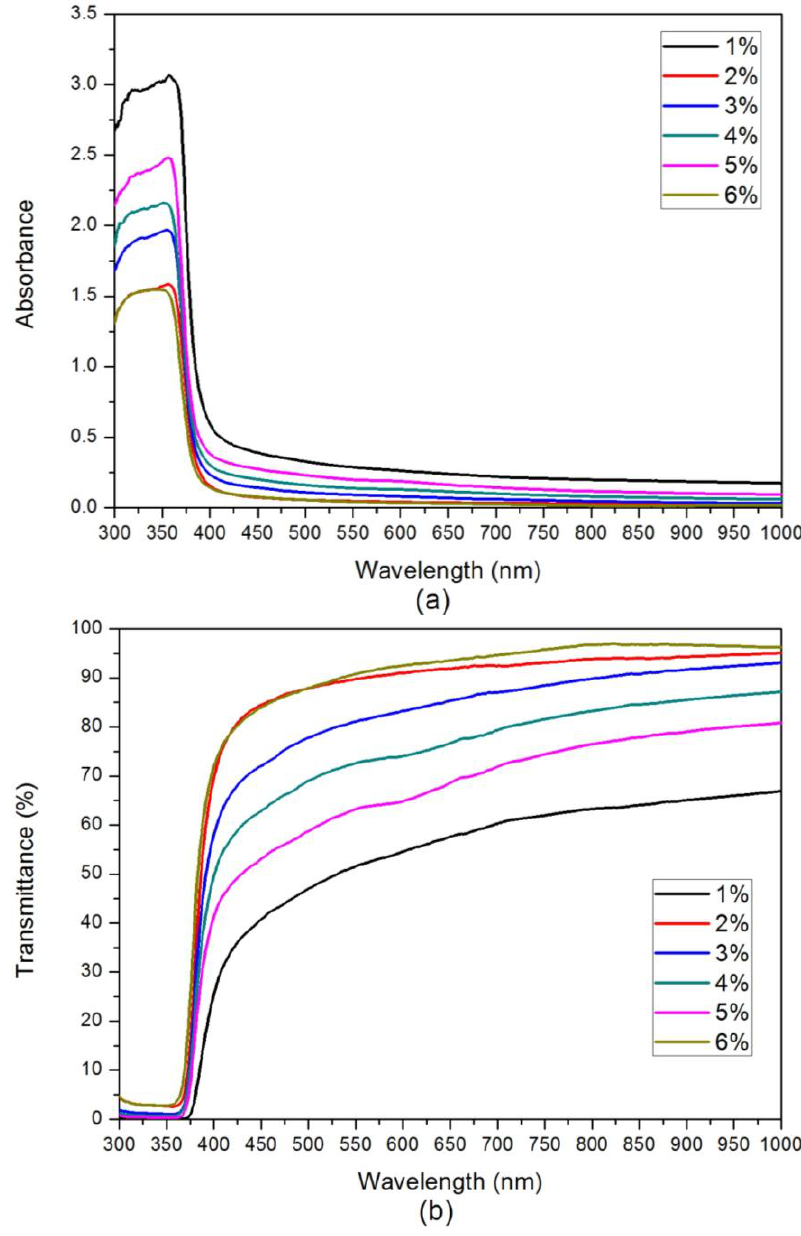
Figure 3. ( a ) Absorption curves and ( b ) optical transmittance